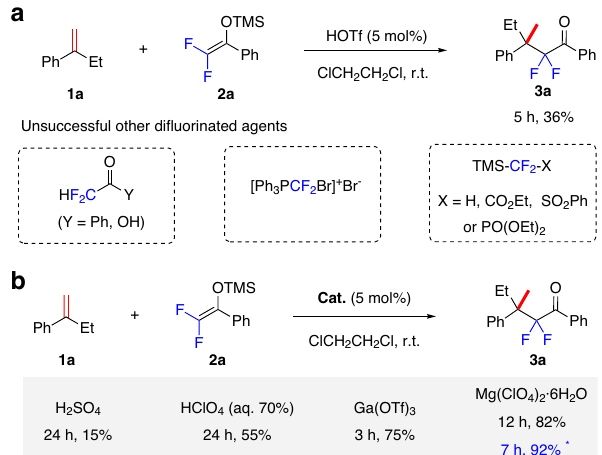
Fig. 2 The development of Markovnikov hydrodi fl uoroaklylation of alkenes. a Performance of different di fl uoro reagents. b Comparing different acid catalysts. *With 10 mol% Mg(ClO 4 ) 2 ·6H